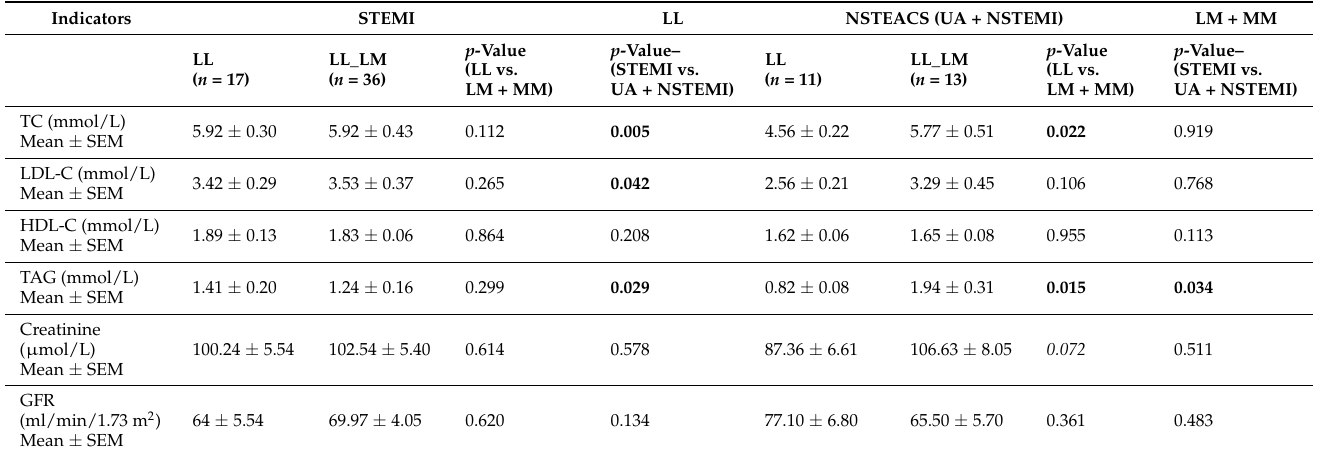
Figure 2. The serum lipid profile markers in patients with different PON1 L55M genotypes and diagnosis. The data are presented as mean ± SEM (standard error of mean). (a,b and c—differences between the STEMI and NSTEACS (UA + NSTEMI) with LL genotype; d—difference between the STEMI and NSTEACS (UA + NSTEMI) with LM + MM genotype; # and &—difference between LL and LM + MM genotypes of patients with NSTEACS). Table 5. The serum lipid profile markers and the markers for renal function in patients with dif- ferent PON1 L55M genotypes and diagnosis. The data are presented as mean ± SEM (standard er- ror of mean).